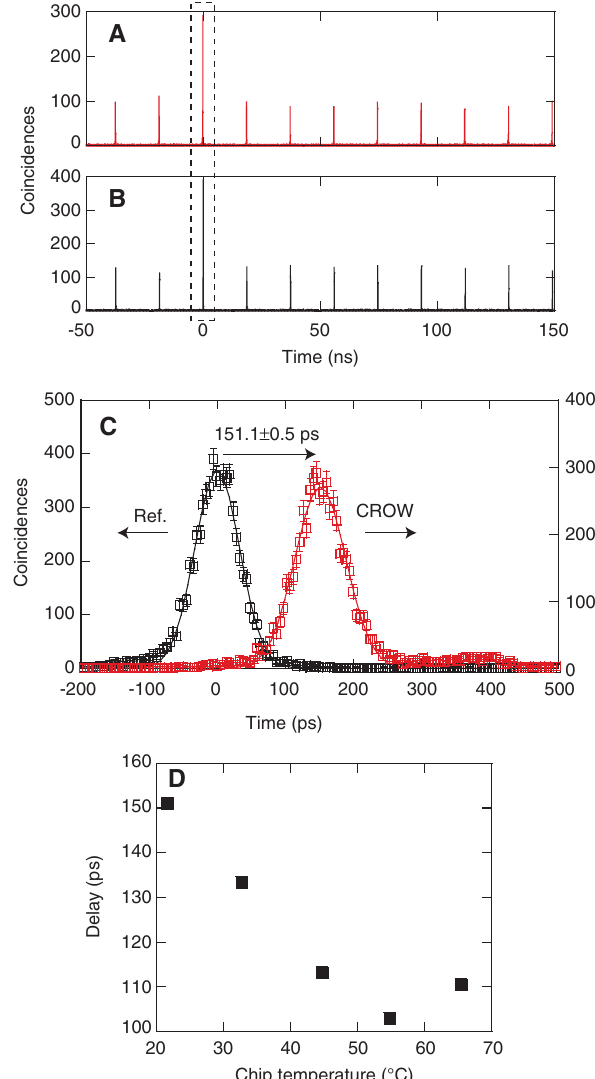
Figure 11: On-chip buffer experimental results. (A, B) Time interval histograms when the signal photons passed through the (A) CROW and (B) reference waveguide. (C) Enlarged main peaks observed in dashed box in (A) and (B). The red and black squares show the histograms obtained with the CROW and the refer- ence waveguide, respectively. (D) Delay caused by the CROW as a function of chip temperature